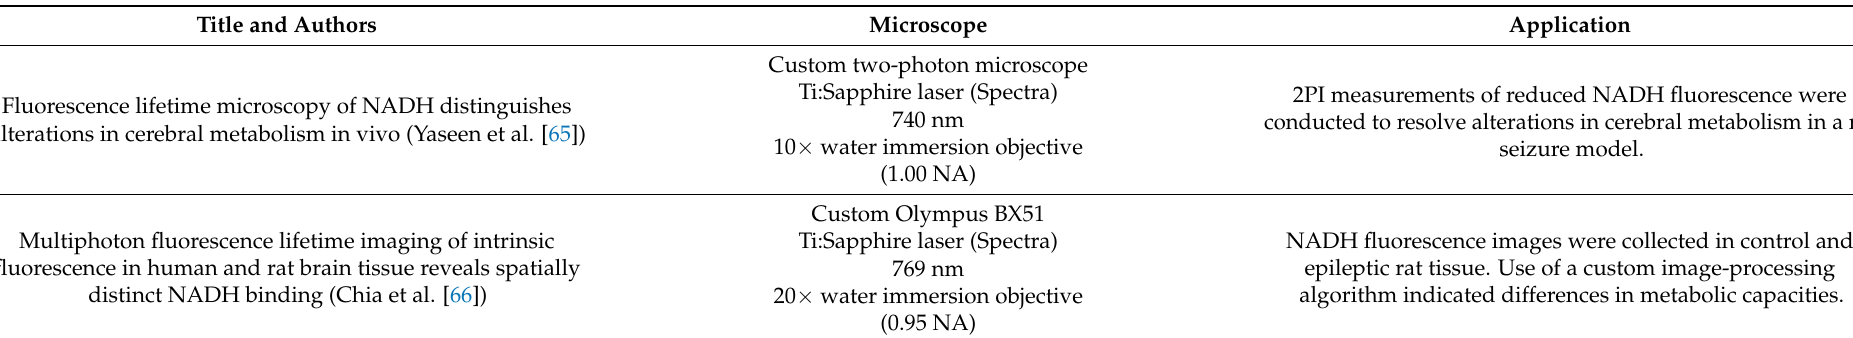
Table 6. Neurometabolism—data abstraction table catalogues the type of two-photon microscope used and how 2PI was applied in each study within this group of